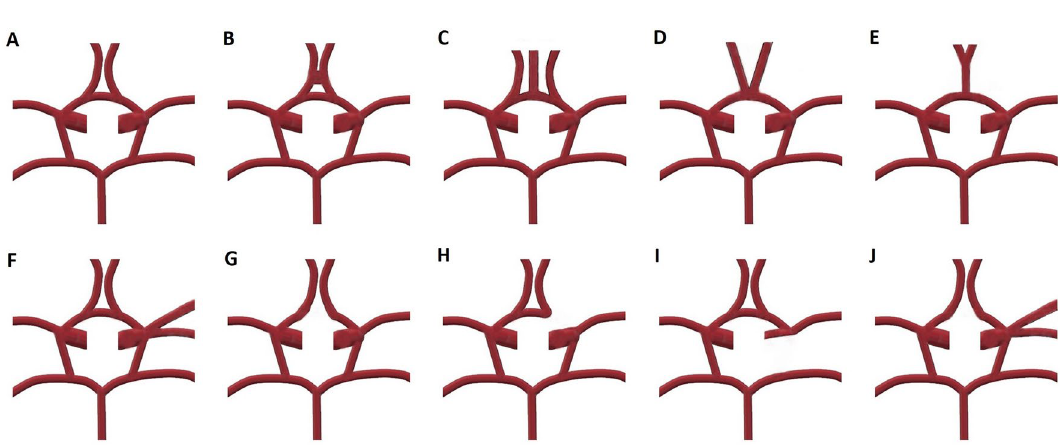
Figure 3. Schematic diagrams showing the morphological variations in the anterior part of the circle of Willis (COW). Type A: normal anatomical morphology in an adult. Type B: more than one AComs, Type C: the median artery of the corpus callosum arises from Acom, Type D: fusion of the anterior cerebral arteries over a short distance, Type E: A2 segments of anterior cerebral arteries are observed distally after a common trunk, Type F: the middle cerebral artery originates from the ICA as two distinct trunks, Type G: hypoplasia or absence of ACom, Type H: one of the anterior cerebral arteries have an absent or hypoplastic A1 segment, and the contralateral anterior cerebral artery gives rise to both A2 segments, Type I: hypoplasia or an absence of an ICA. The anterior cerebral artery gives rise to both A2 segments in this variance. It supplies retrograde blood flow to the ipsilateral A1 segment, Type J: hypoplasia or absence of ACom, and MCA arises as two distinct trunks ( ACom anterior communicating artery, ICA internal carotid were present in these individuals. A partially complete circle (P) represented individuals with a morphological variant in either the anterior or posterior compartment. An incomplete circle (I) represented a variant in both anterior and posterior compartments of the COW. The prevalence of each anatomical variation was documented. The patient population was also presented with age distribution, sex difference, and configuration of COW. Each anatomical classification of COW variation was shown with percentages, and the results of the vessel diam- eters of each component of the COW were presented on mean ± standard deviations. The vessel diameters were measured and presented according to age and sex differences. Regarding age and sex differences, independent sample t-test was carried out to calculate the significance of the difference between vessel diameters. To deter- mine the significance of the study results between the integrity of the COW and vessel diameters, analysis of variance (ANOVA) has been used. Before analyzing the sex and age differences with regard to vessel calibers, data distribution was controlled with a Shapiro–Wilk test. There was no normal data distribution for ACom and BA, and both A1 and P1 segments to compare the sex and differences and to compare different configurations